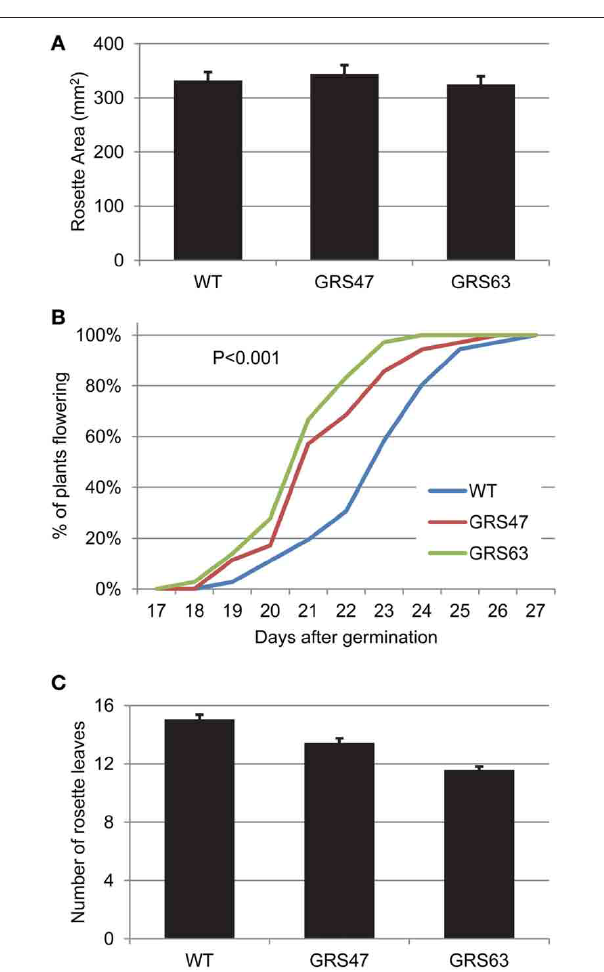
FIGURE 6 | Analysis of vegetative growth and the transition to reproductive growth in WT and transgenic lines. (A) Rosette area at 17 dag; average and SE values from 12 replicates. (B) Percentage of plants flowering relative to days post germination. (C) Number of rosette leaves at the time of flowering. Average and SE, n = 36.